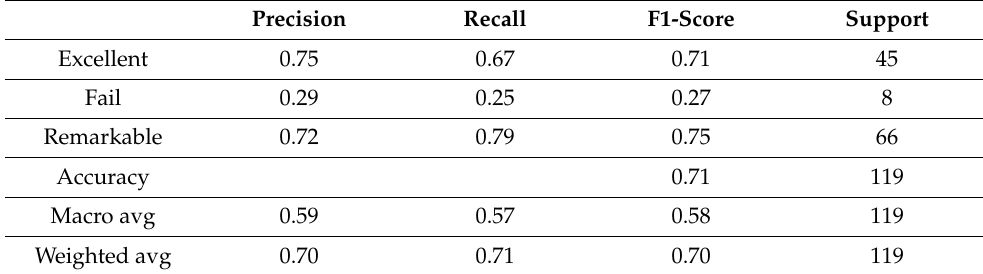
Table 2. Statistical data of the simulation, taking into account information from the whole semester. Precision